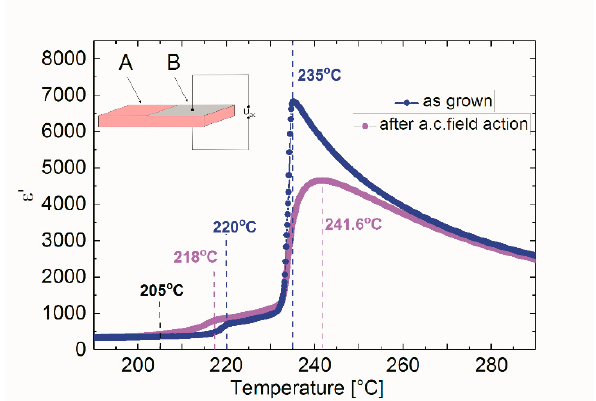
Figure 10 . Temperature changes of electric permittivity of the virgin crystal part A (blue) and part B of crystal exposed to alternating electric field (magenta). The inset shows the geometry of electrodes used for dielectric and electromechanical measurements. The measuring field frequency in dielectric measurements was 1MHz and the electric field strength in electromechanical measurements was 3kV/cm [37].